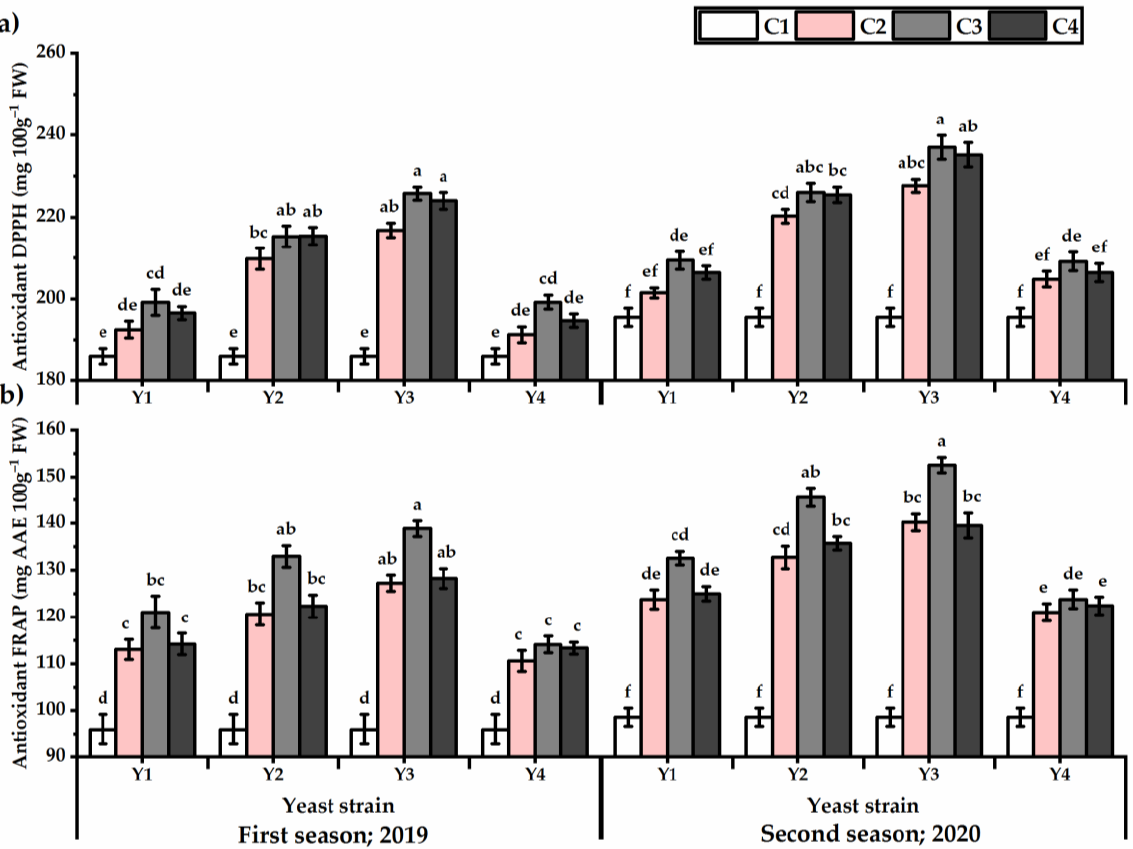
Figure 6. DPPH (mg 100 g − 1 ) ( a ) and FRAP (mg AAE 100 g − 1 FW) ( b ) of Plectranthus amboinicus (Lour.) Spreng. plants subjected to Rhodotorula muciligenese (Y1), Candida sake (Y2), Candida apicola (Y3), and Candida kunwiensis (Y4) yeast strains foliar application at 0 (C1), 1 × 10 4 (C2), 1 × 10 7 (C3), and 1 × 10 9 (C4) CFU mL − 1 concentrations during 2019 and 2020 seasons. Data are mean value ± SE. Means with different letters for each season significantly differed, using Tukey’s test at p ≤ 0.05 level, n = 15.